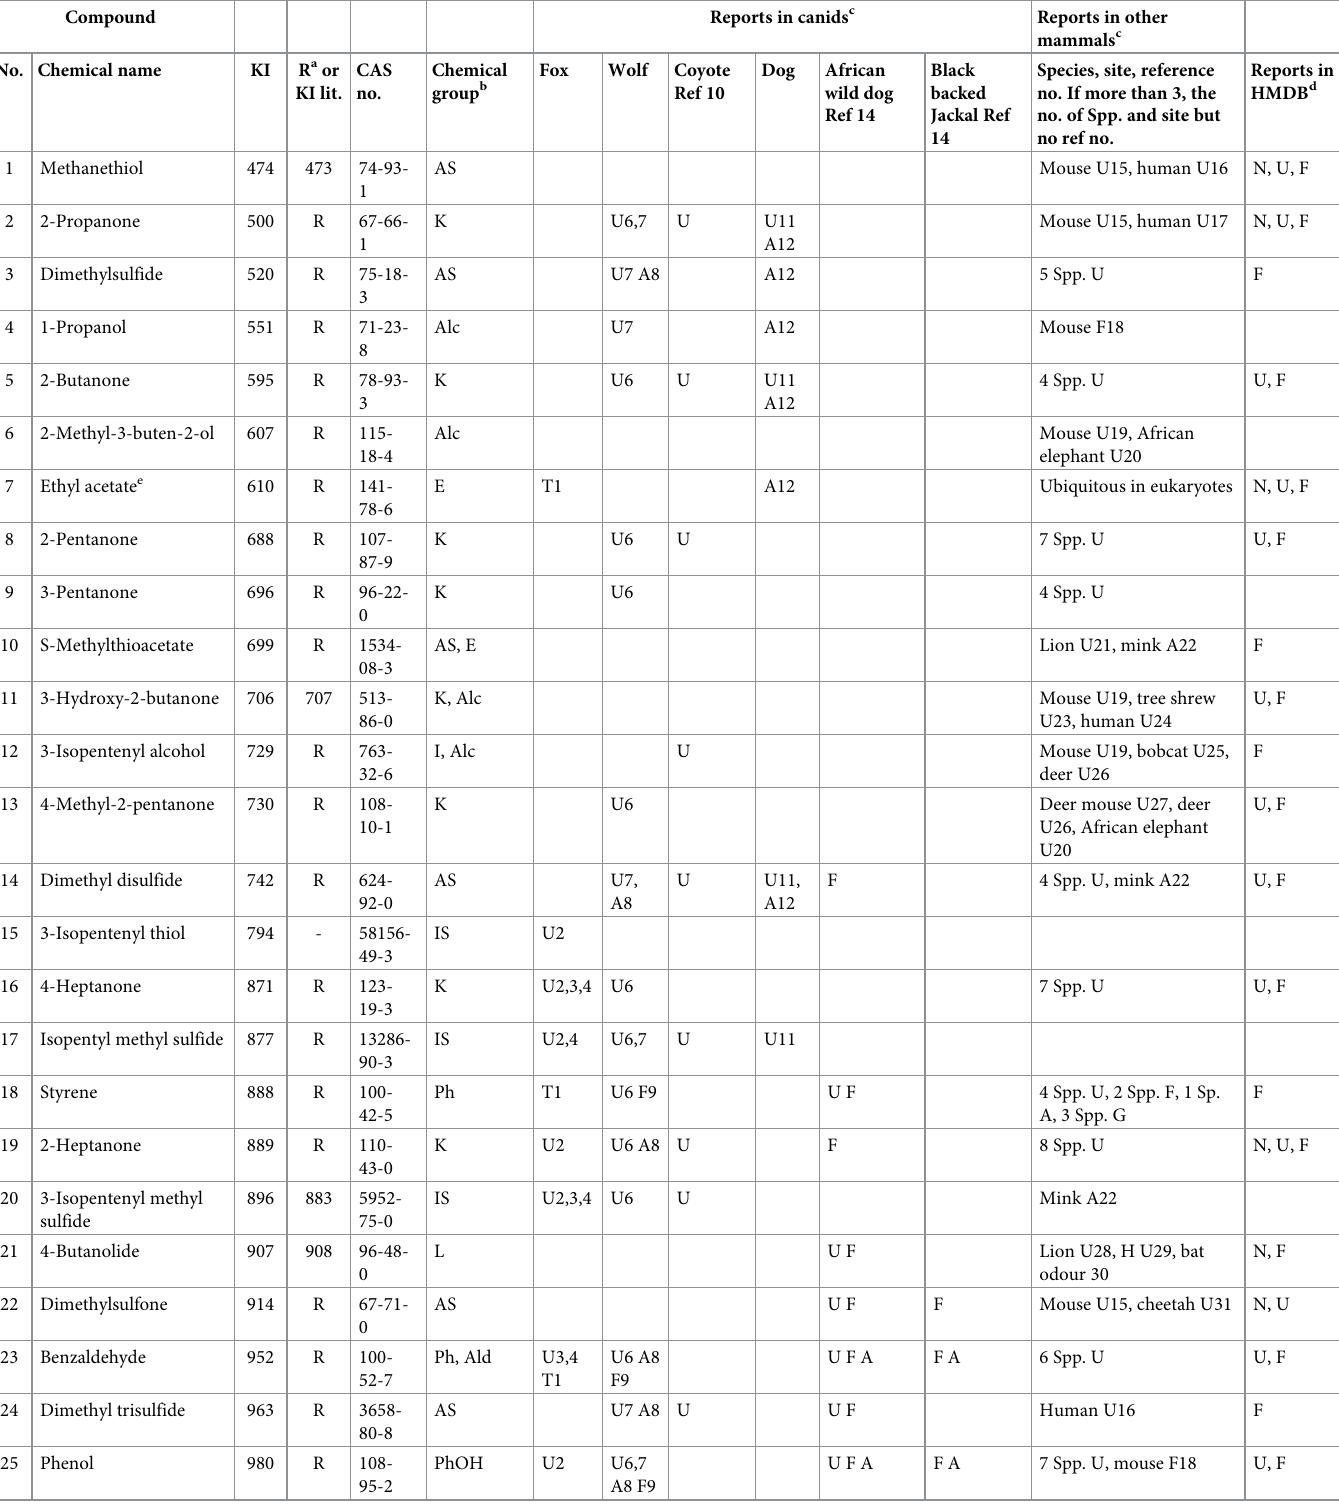
Table 1. Compounds found in fox urine and their reported findings in foxes, other canids and other mammals. Compound Reports in canids